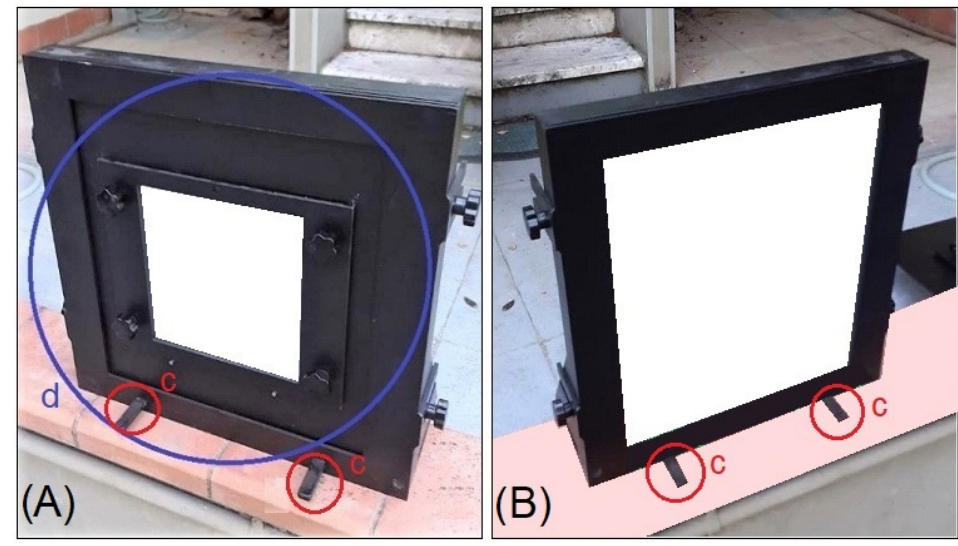
Figure 5. Clamping frame mounting different panel sizes. ( A ) Frame for 500 × 500 mm panels: (c) lower panel supports. ( B ) Frame for 300 × 300 mm panels: (d) smaller panel clamping [29] .